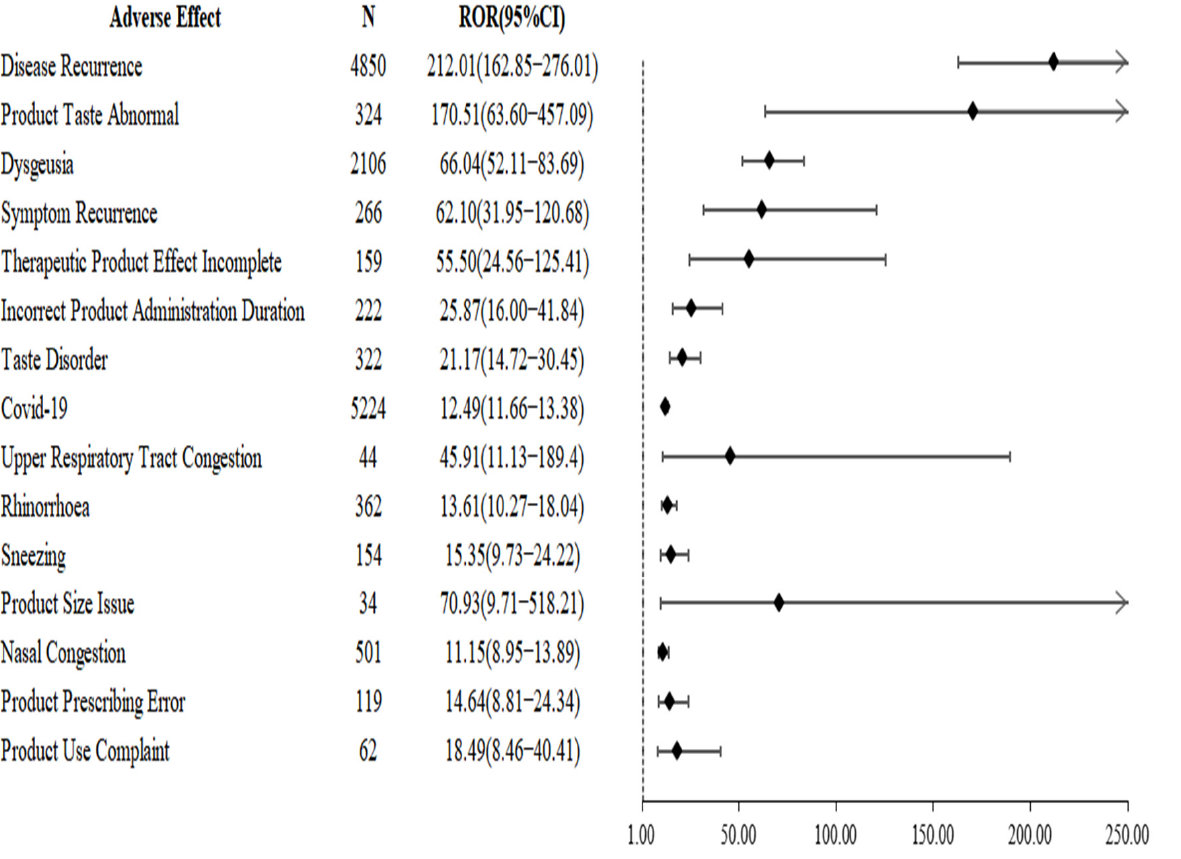
Figure 2. Signals of adverse events associated with nirmatrelvir/ritonavir use.